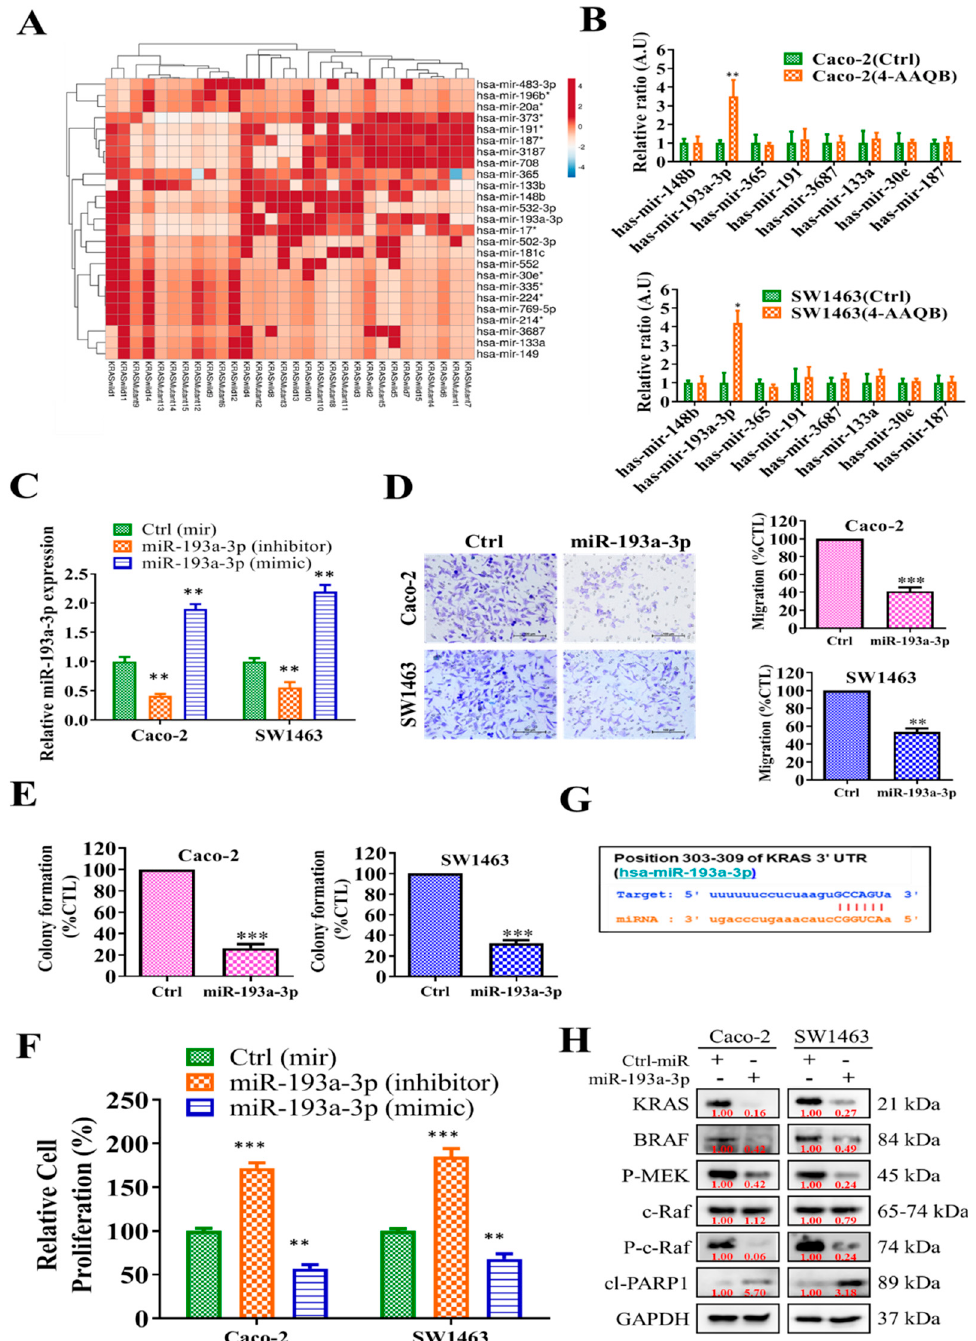
Figure 5. miR-193a-3p impairs the growth and tumorigenicity of KRAS wild-type and KRAS mutant CRC cells. ( A ) Heatmap showing the 25 most downregulated miRs in clinical samples of KRAS-mutated cells in comparison with KRAS wild-type cells downloaded from GEO (GSE66548). ( B ) The quantitative reverse transcription-polymerase chain reaction analysis showed that the 4-AAQB treatment significantly induced the expression of miR-193a-3p in both KRAS mutant and wild-type CRC cells. ( C ) Overexpression and inhibition of miR-193a-3p in CRC cells. ( D , E ) Transwell assay was performed to assess the migration ability and colony formation ability of Caco-2 and SW1463 cells after transfection with miR-193a-3p (mimic). ( F ) CRC cells proliferation after miR-193a-3p (mimic or inhibitor) transfection was detected based on SRB assay. ( G ) Bioinformatics analysis indicated that KRAS is predicted as a target gene of miR-193a-3p. ( H ) Western blot analysis of KRAS/BRAF, p-MEK, MEK, p-ERK, ERK, craft, and PAPR1 expression normalized by GAPDH housekeeping gene in the indicated CRC cells. * p < 0.05; ** p < 0.01; *** p < 0.001. Scale bar 100 µM.